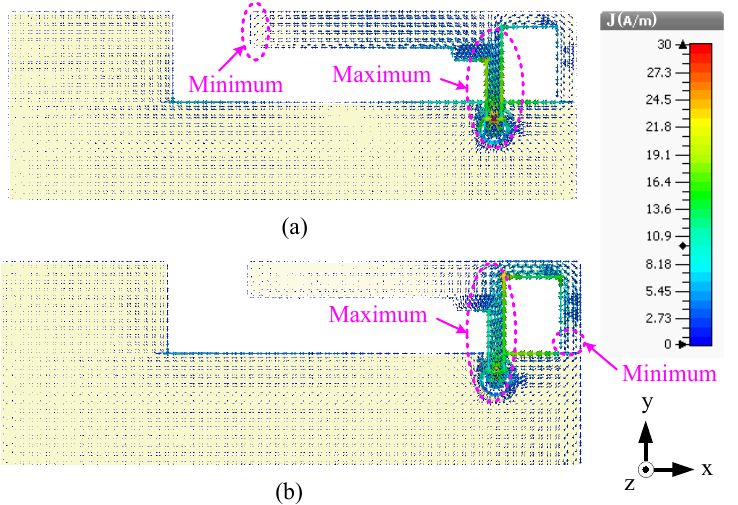
Figure 3. Surface current distributions of the planar antenna (Ant#1) operating in the LSA bands at ( a ) 1.8 and ( b ) 2.6